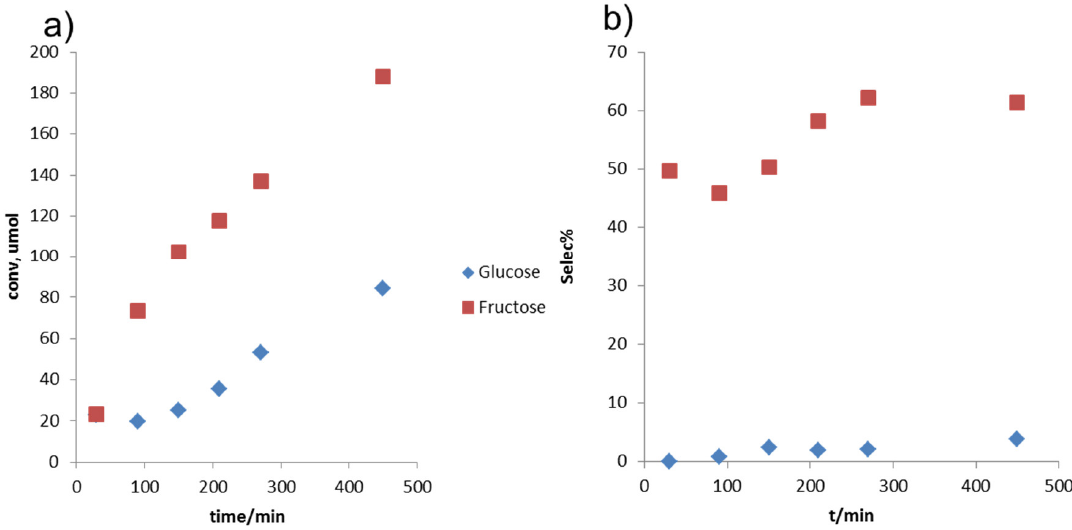
Figure 6. Reaction results of glucose/fructose conversion in THF/water solvent. ( a ) Conversions; ( b ) selectivities. Reaction conditions: solvent of THF/water 9:1 ( v / v ), reaction temperature of 160 °C, 2 wt % glucose/fructose, 5 mg each of Lewis and Brønsted catalyst/g of reaction media.